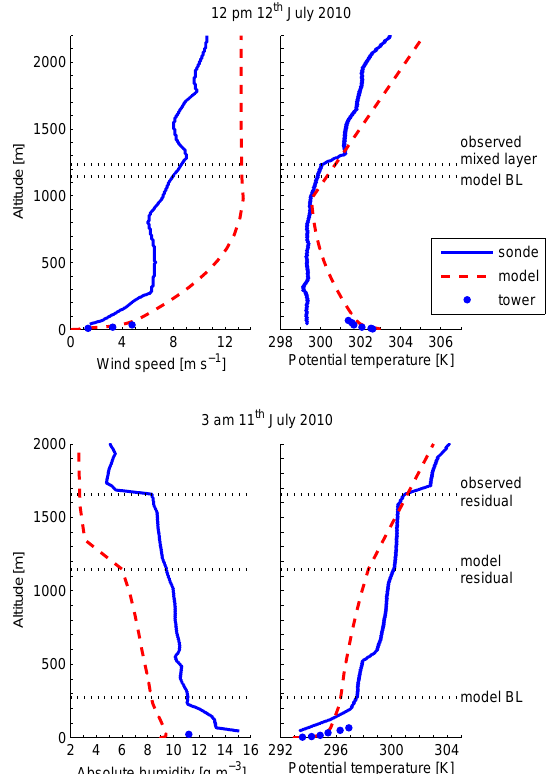
Figure 3. Examples of modelled and observed vertical profiles at Figure 2. Examples of modelled and observed vertical profiles at 12p.m. on 12 July (top) and 3a.m. 12p.m. on 12 July (top) and 3a.m. on 11 July (bottom). Solid lines on 11 July (bottom). Solid lines are data obtained from radiosonde observations, and the dots are are data obtained from radiosonde observations, and the dots are 30 min averages from the SMEAR II tower. The model values are representing the 30 min during 30min averages from the SMEAR II tower. The model values rep- which the soundings were made. resent the 30min during which the soundings were